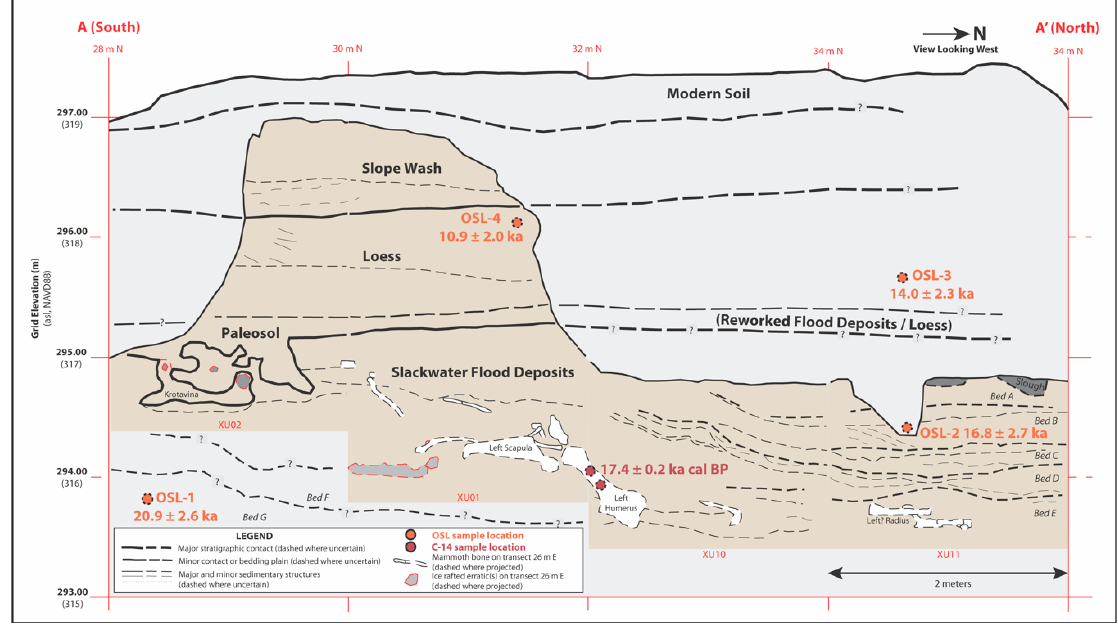
Figure 6. Stratigraphic interpretation of the CCMS excavation along a cross section (tan shading) looking west. See Figures 4a and 5 for location. The major stratigraphic units (projected to background and foreground excavation walls, shaded in gray) include (from oldest to youngest): a sequence of slackwater flood deposits, a paleosol, loess, and colluvial slope wash. Note the location of OSL and radiocarbon samples.